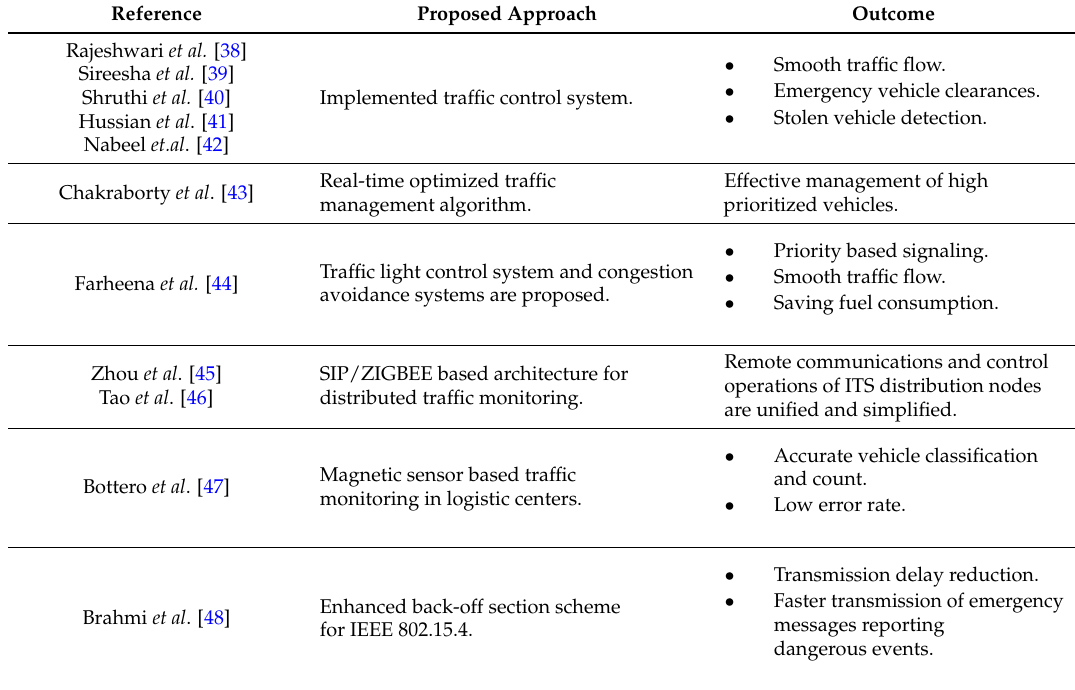
Table 7. Summary of priority-based traffic management